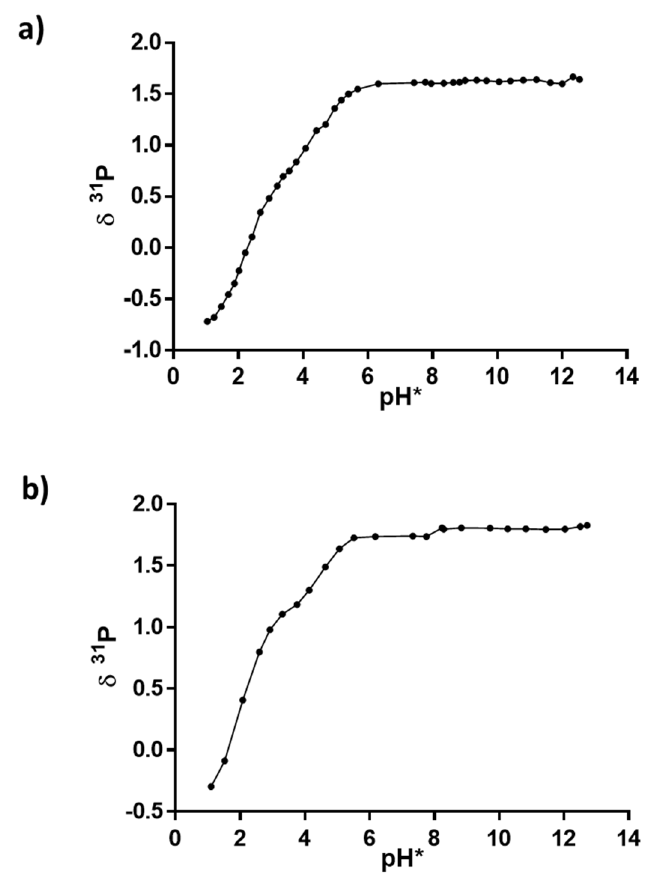
Figure 5. Plot of 31 P chemical shift vs. pH* for 1 ( a ) and 2 ( b ).